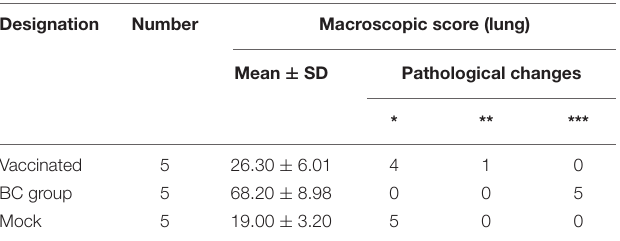
TABLE 5 | Mean value ± SD of macroscopic scores of the gross lung lesion in three